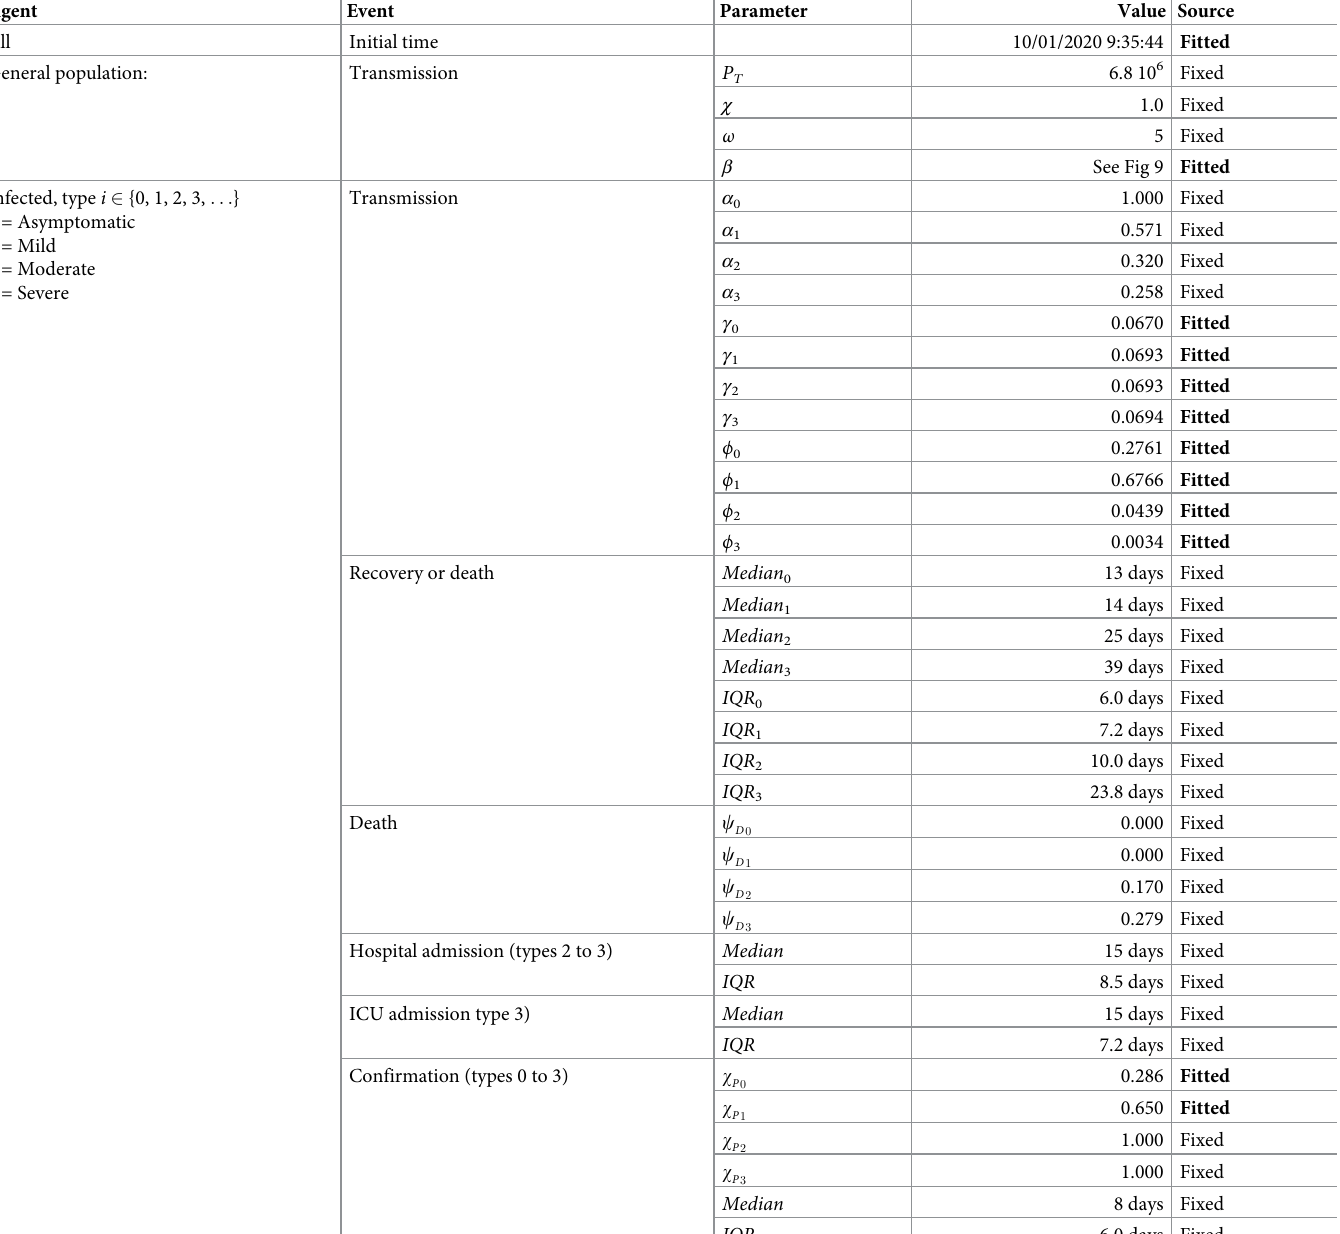
Table 3. Values of all the parameters used in the